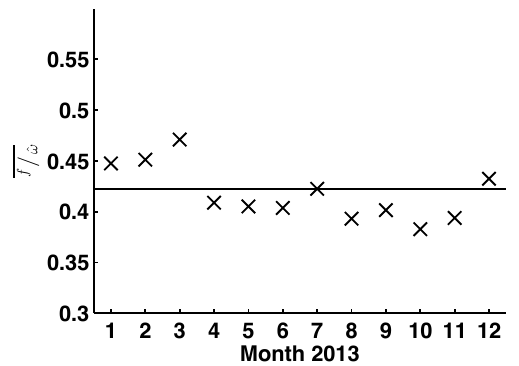
Figure 4. Mean monthly values of f/ ˆ ω for year 2013